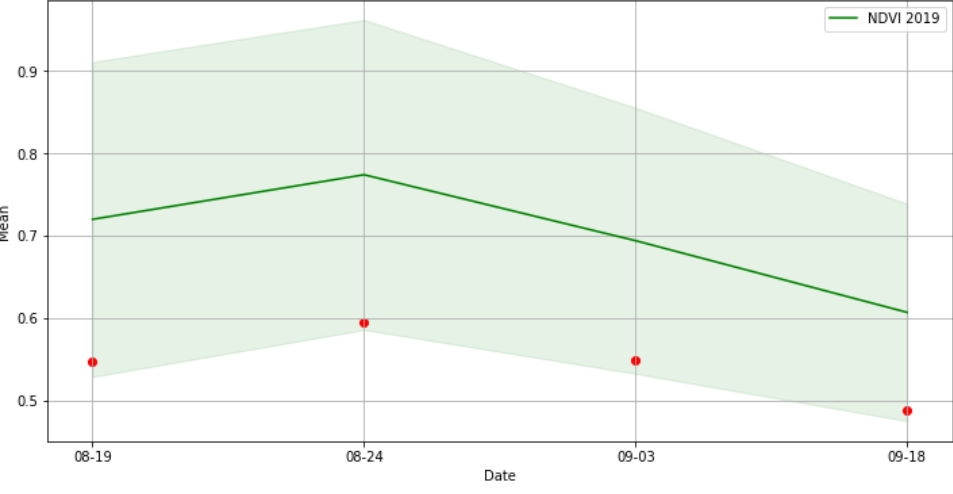
Figure 20. Phenology of the plot suspected of not meeting the